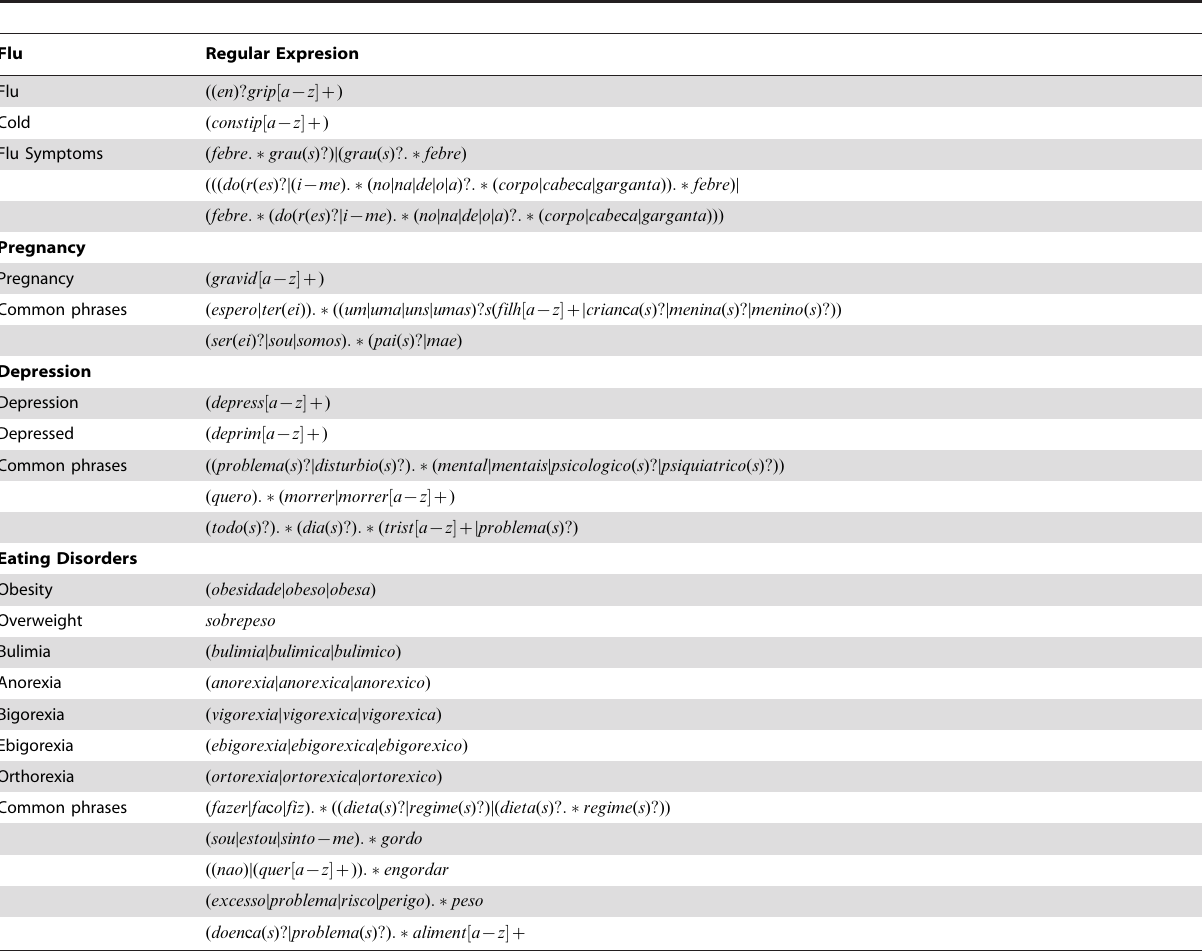
Table 2. Regular expressions for detecting health disorders in Portuguese tweets.